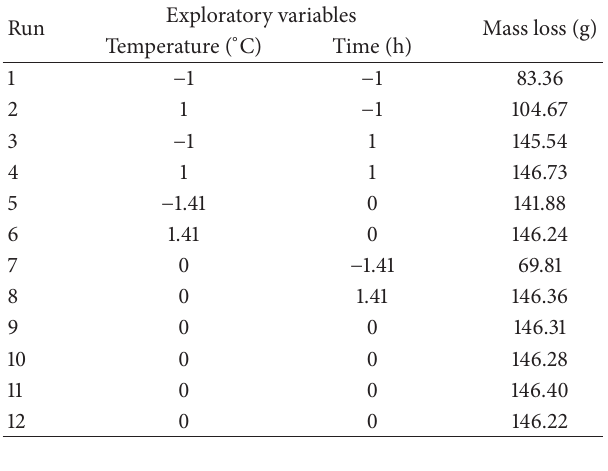
Table 1: Coded values and corresponding actual values used in the first experimental design.